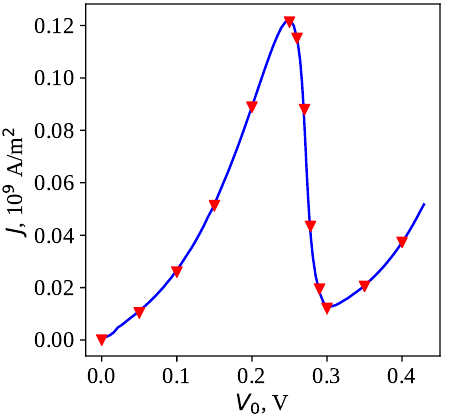
Figure 3. Current–voltage characteristic for the resonant tunneling nanostructure from [23]. The solid blue line is the solution from [23], and the red dots represent the solution obtained as a result of our calculations.